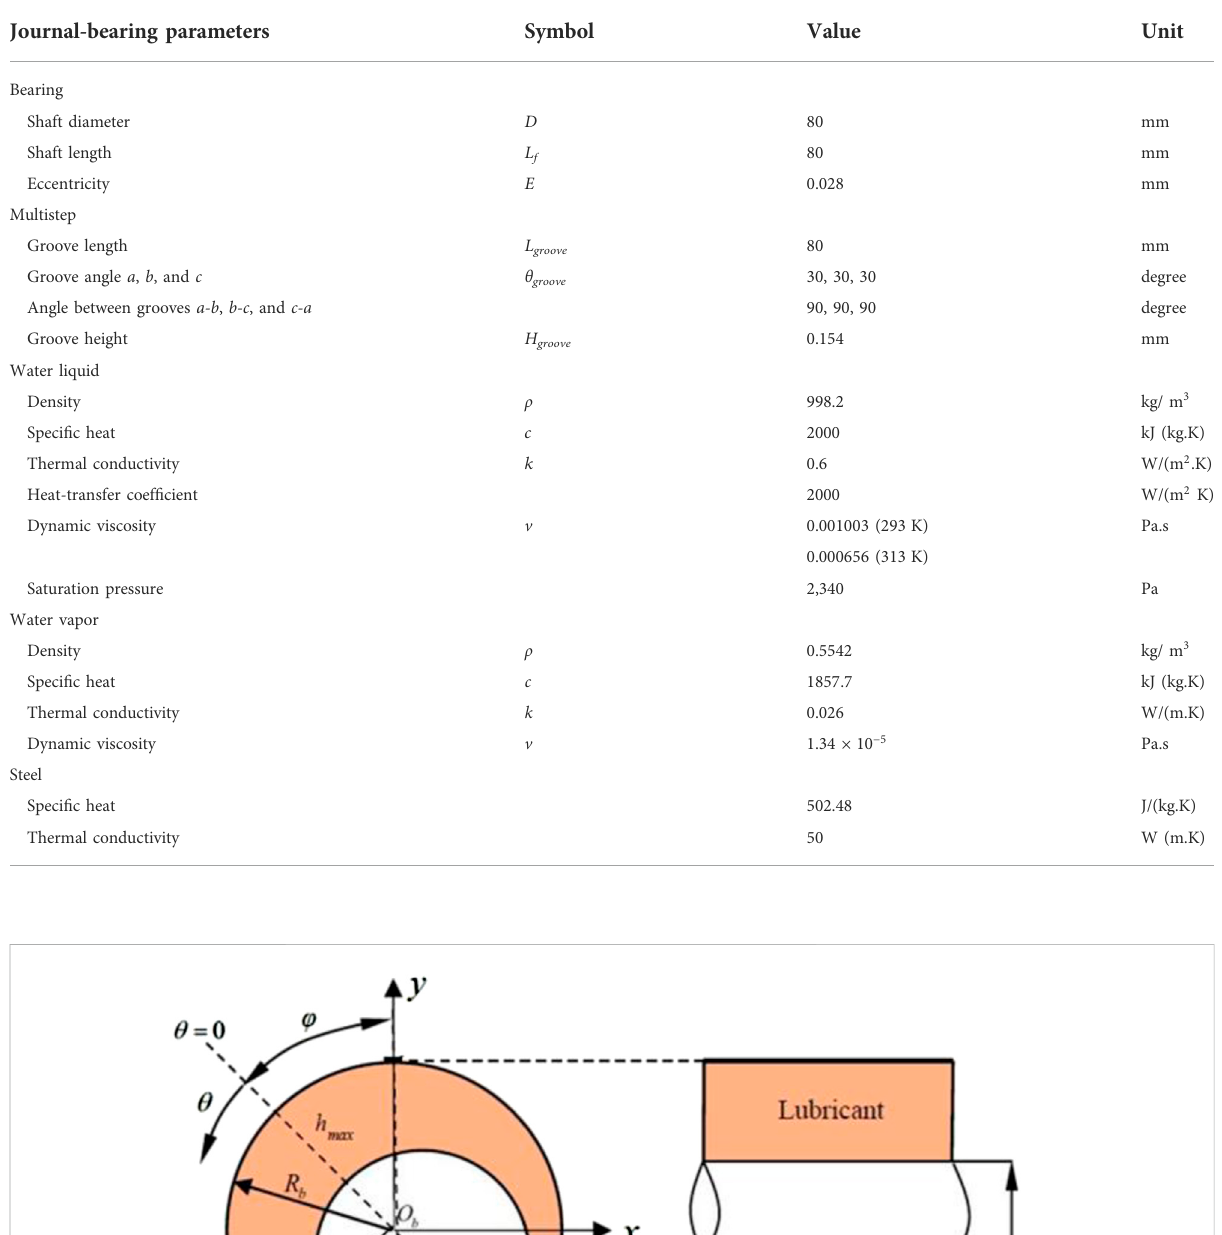
TABLE 1 Parameters of journal bearings.